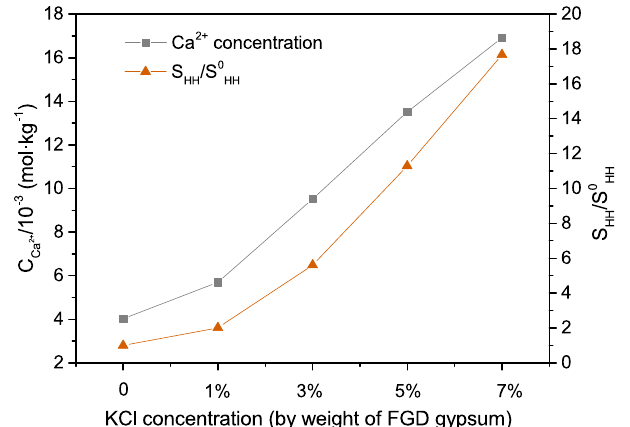
Figure 3. Influence of KCl on Ca 2 + concentration and S HH /S 0 HH in glycerol (65 wt%)-water solutions at 90 °C.